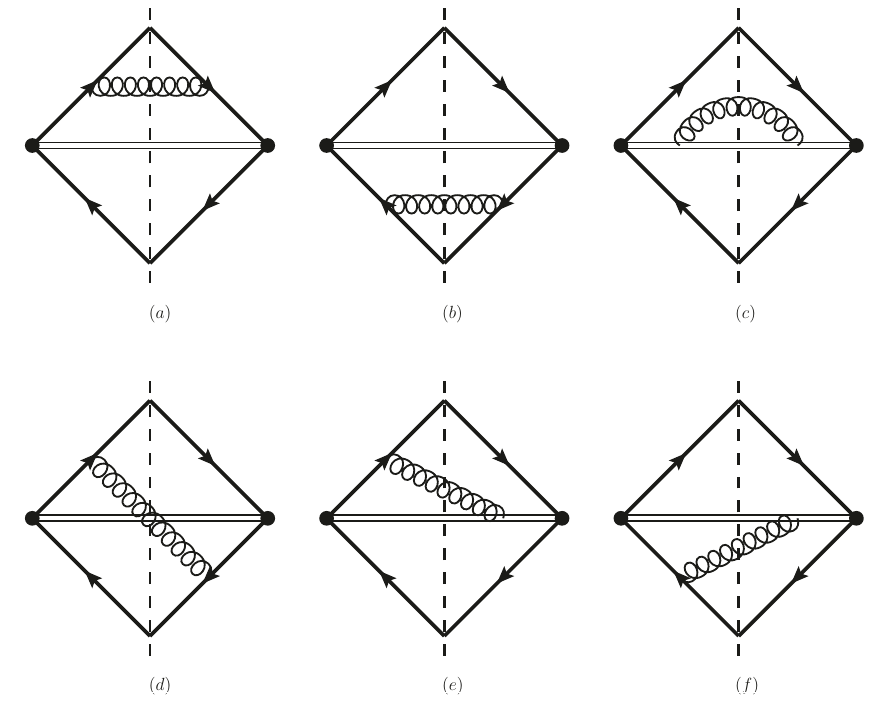
Figure 3 . The real corrections of SGD at